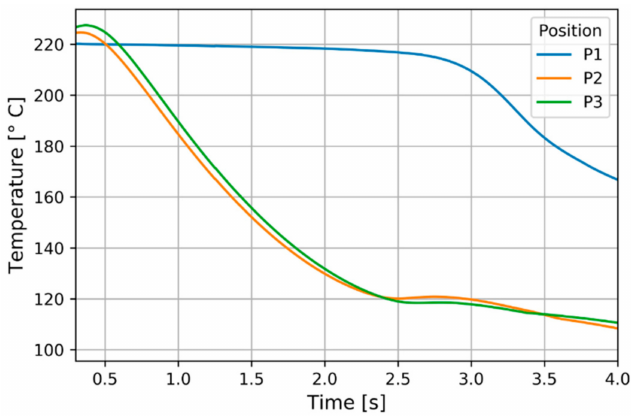
Figure 9. Temperature evolution at the observed positions (mid-thickness).